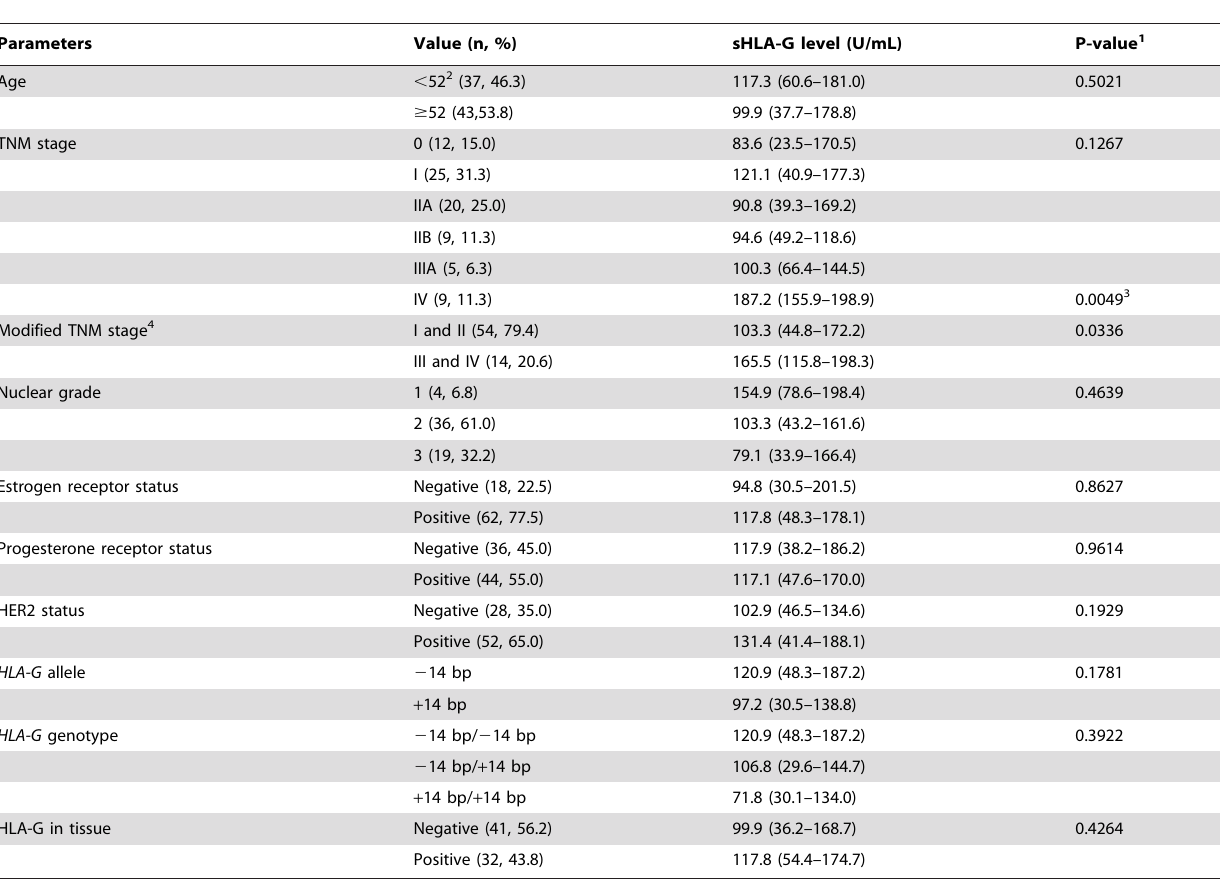
Table 2. sHLA-G based on clinicopathological parameters, HLA-G expression in tissue, and the HLA-G 14-bp sequence status.